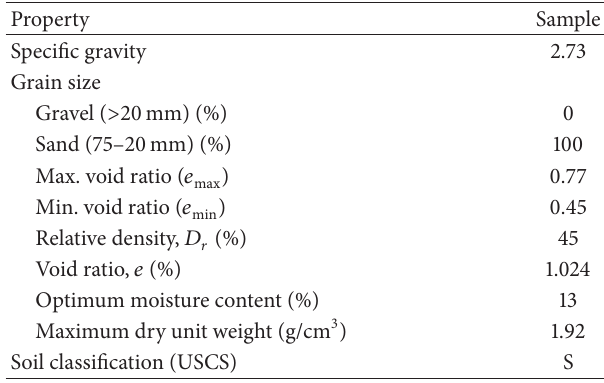
Table 1: Properties of the cement.